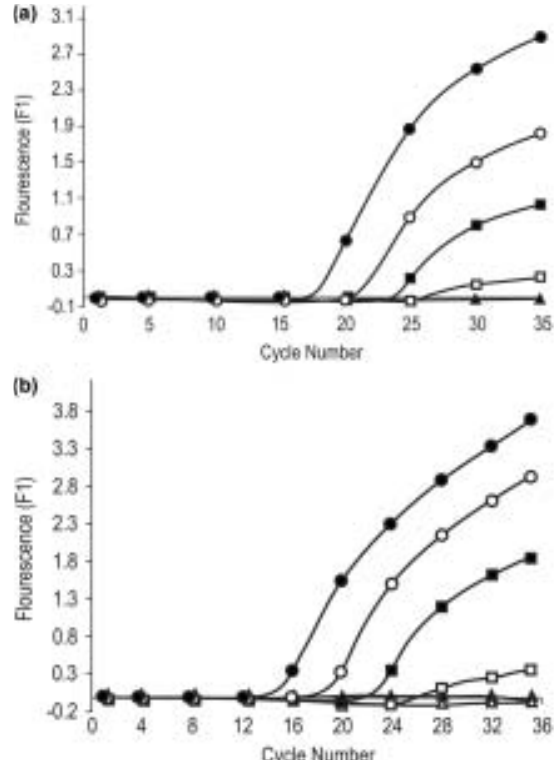
Figure 3 The limit of detection of the real-time Hybridization PCR assay for GBS and Taqman assay for E. coli were determined by serial dilution of extracted GBS or E. coli DNA before real-time PCR using LightCycler TM . Each concentration was performed in triplicate and the average was used in the plot (solid circle, 10 ng/rxn; open circle, 1 ng/rxn; solid square, 100 pg/rxn; open square, 10 pg/rxn; closed triangle, 1